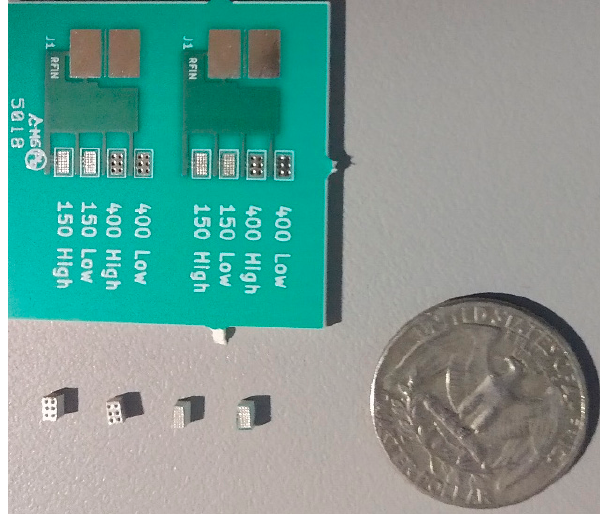
Figure 3. Pre- and post-extraction MVAs.